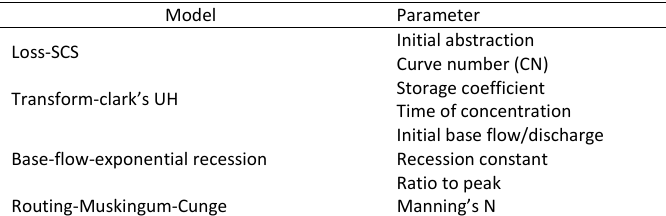
Table 1: Input parameters for event‐based hydrological modeling